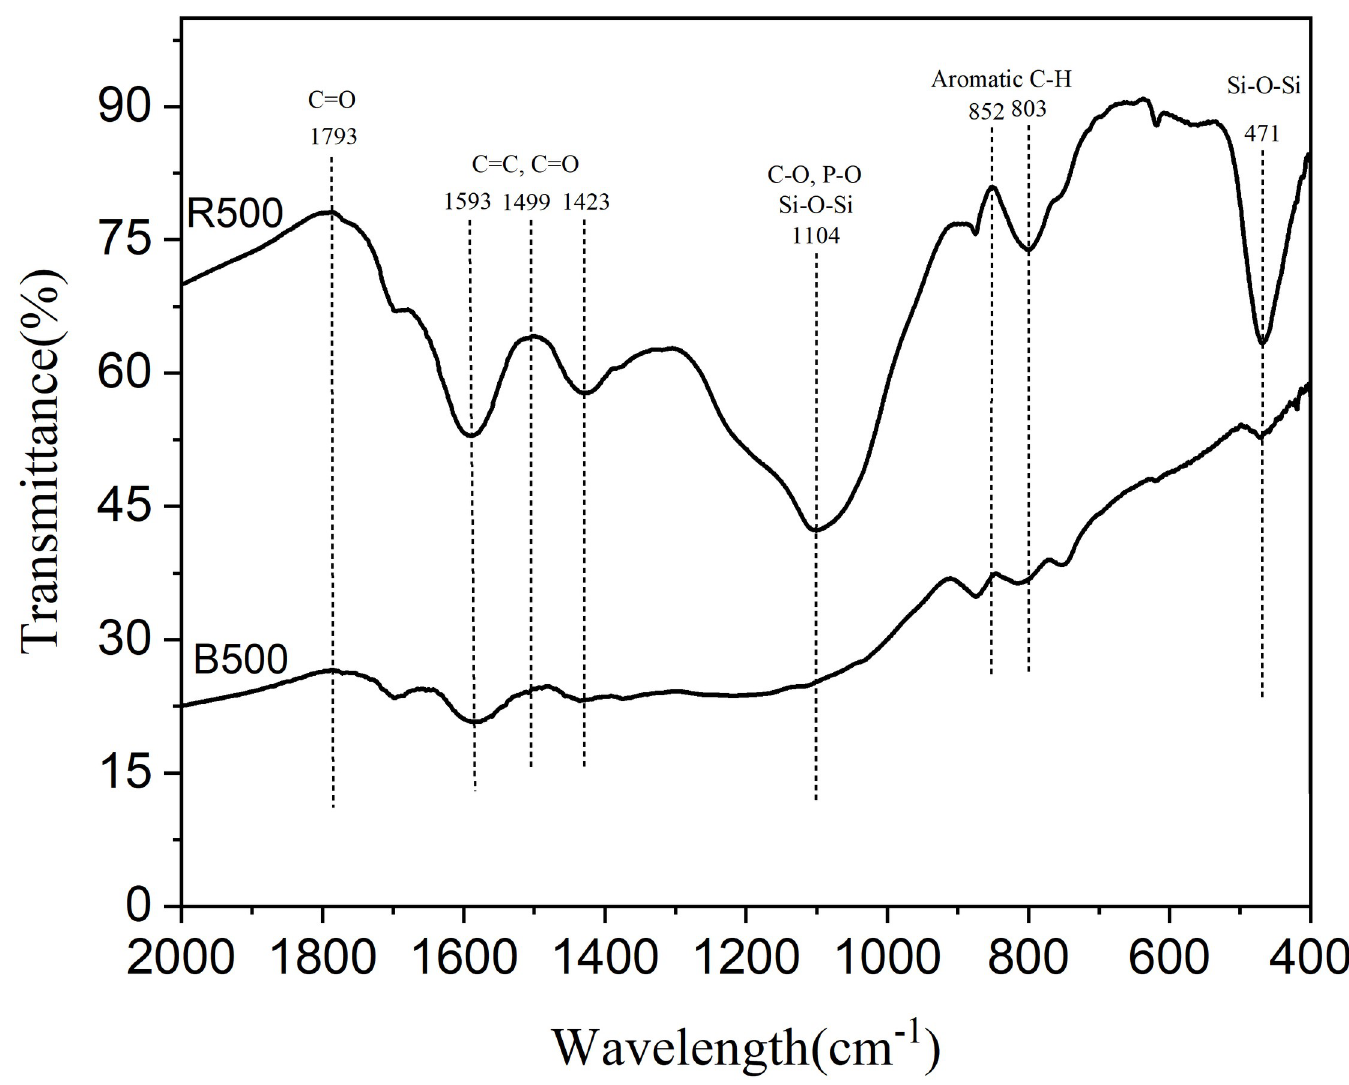
Fig 3. Fourier Transform Infrared (FTIR) spectroscopic analysis of